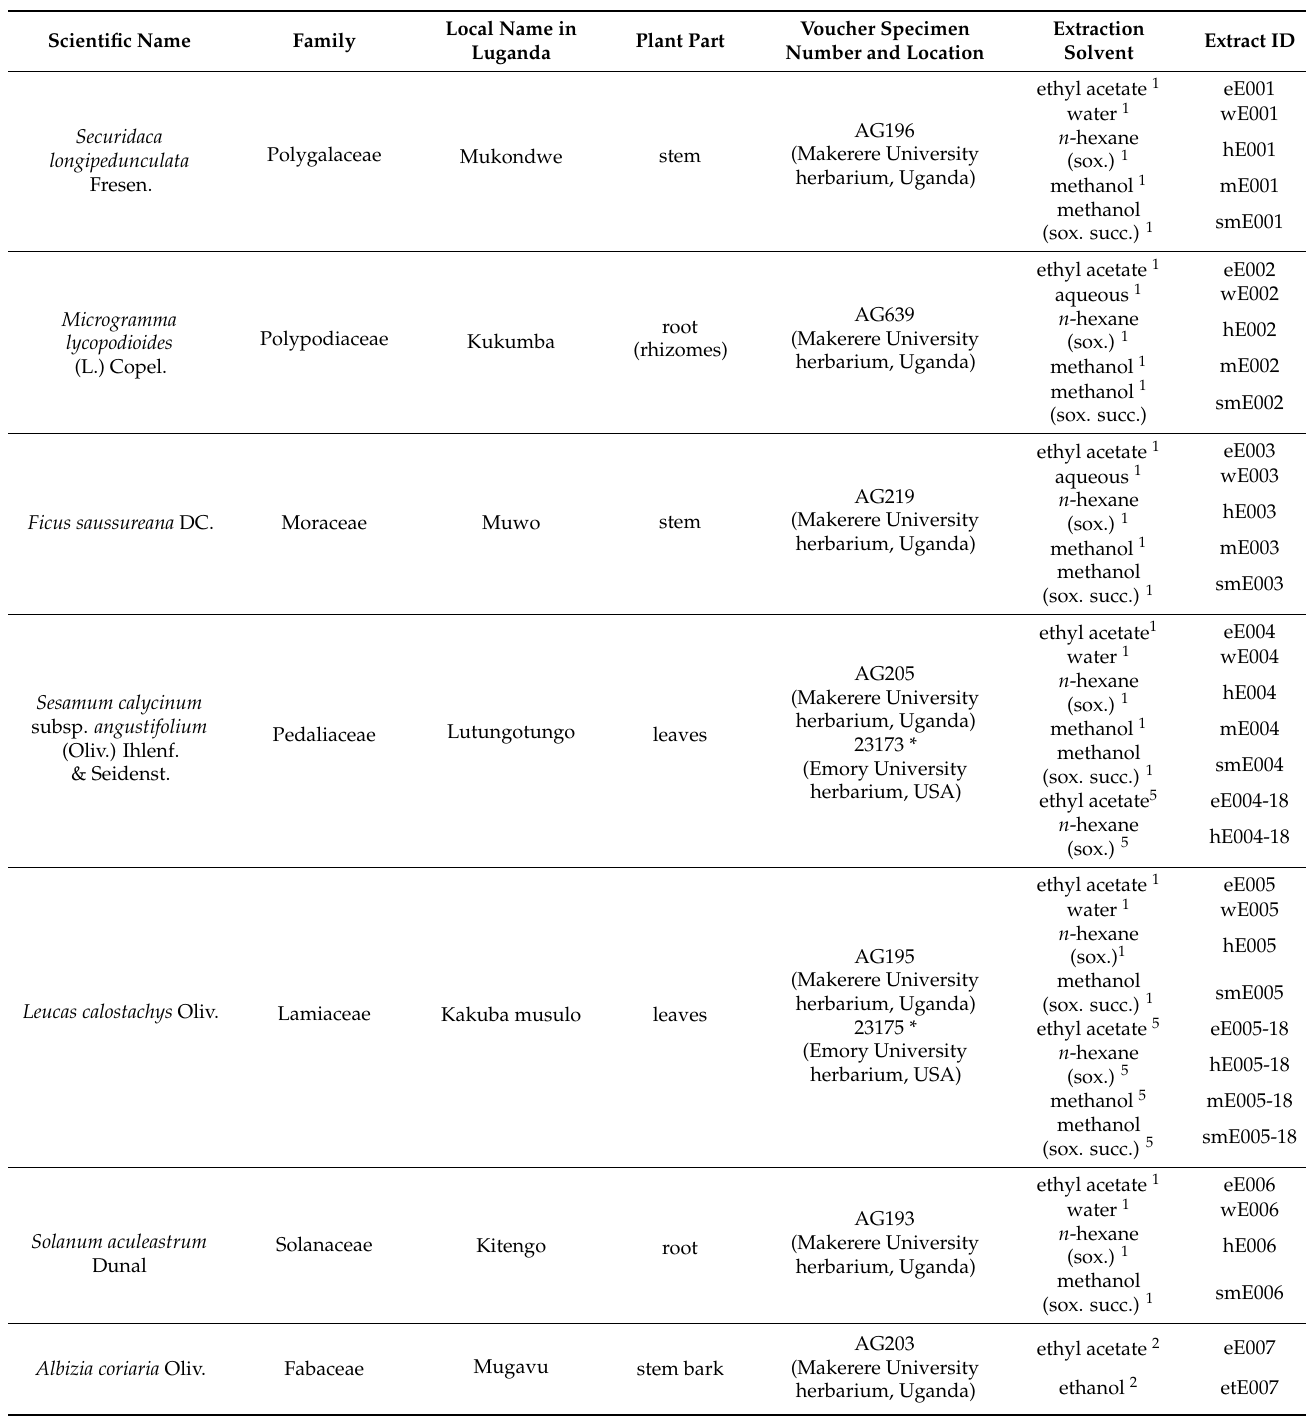
Table 1. Description of collected plant species and different extracts investigated in this